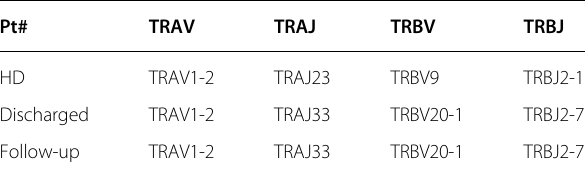
Table 1 The highest TRAV/J usage in each